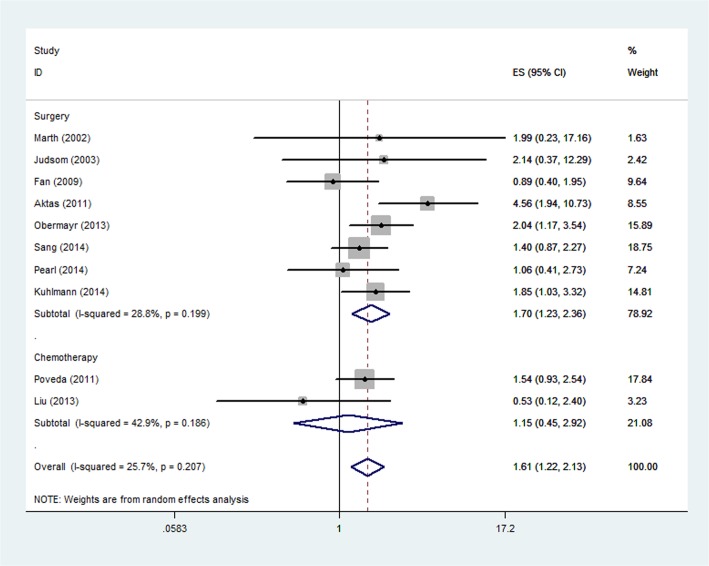
Forest plot showing the meta-analysis of hazard ratio estimates for OS in “Surgery” subgroup and “Chemotherapy” subgroup.Subgroup analysis based on different treatment methods. OS = overall survival.